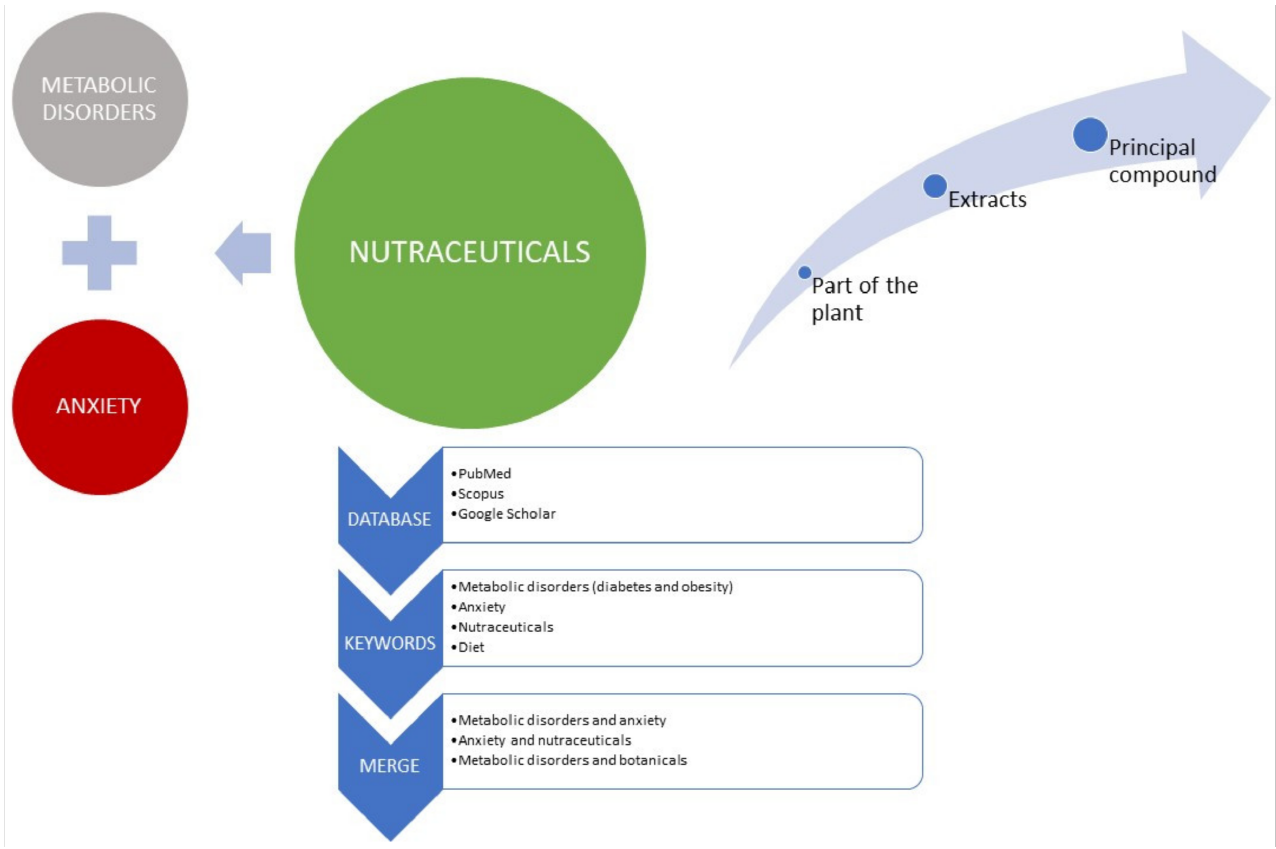
Figure 1. Perspective